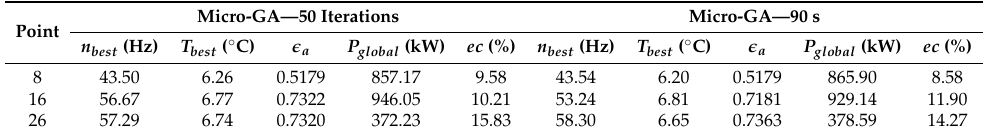
Table 8. Optimal solutions obtained by Micro-GA for the 4 operational points.